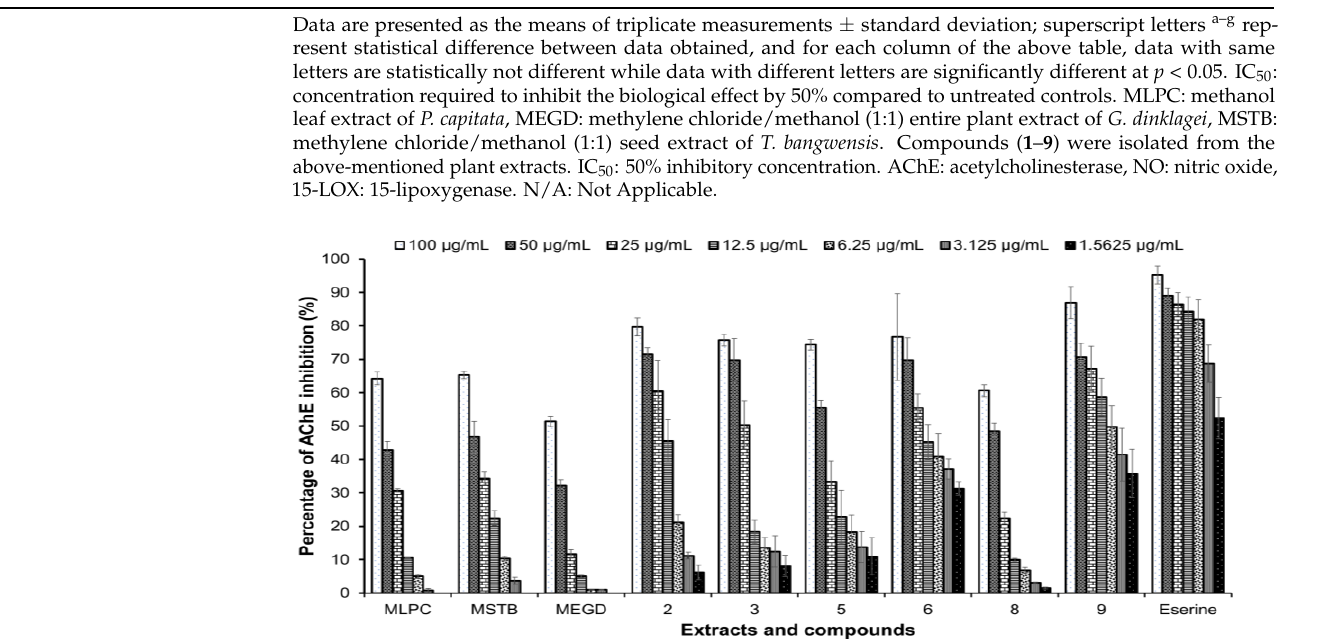
Figure 2. Acetylcholinesterase inhibitory activity of active extracts and compounds at different concentrations. Eserine was used as a positive control. Data are presented as the mean ± standard deviation of three independent experiments. MLPC: methanol leaf extract of P. capitata , MEGD: methylene chloride/methanol (1:1) entire plant extract of G. dinklagei , MSTB: methylene chloride/methanol (1:1) seed extract of T. bangwensis . Compounds ( 2 ), ( 3 ), ( 5 ), ( 6 ), ( 8 ) and ( 9 ) were isolated from the above-mentioned plant extracts. Table 1. Inhibitory concentrations (IC 50 in µg/mL and µM) of crude extracts of Phragmanthera capi- tata, Globimetula dinklagei and Tapinanthus bangwensis and their isolated compounds with reference controls (eserine) or (quercetin).